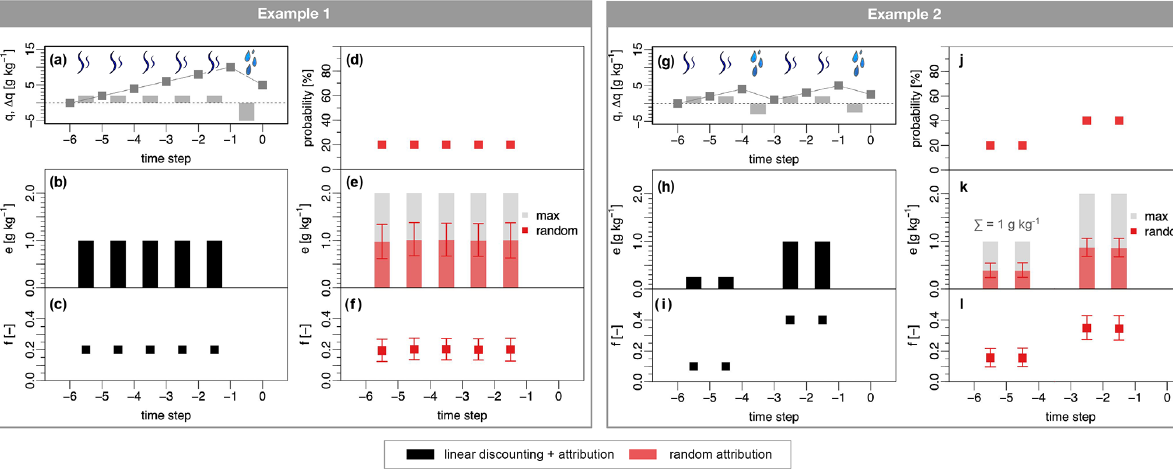
Figure 2. Illustration of backward-tracking precipitation from two idealized air parcel trajectories: (a, g) time series of specific humidity (dark grey lines and points) and specific humidity changes (grey bars) of the air parcels that lose moisture through precipitation at time step 0. The air parcels are each tracked backward in time for six time steps, during which they gained moisture through surface evaporation. In both examples (a, g) , the air parcel gains + 2gkg − 1 of moisture at each source and loses 50% of its specific humidity content during the (final) precipitation event. In the second example (g) , an additional rain event takes place en route at time step − 3, reducing the specific humidity to 1gkg − 1 . (b, h) The absolute contribution of each source to the precipitation event in step 0 as calculated with the linear attribution, assuming perfectly mixed conditions. In (h) , the absolute contributions of time steps − 6 and − 5 are lower because of the rain en route event. (c, i) Relative contributions as calculated with the linear discounting and attribution. (d, j) Probability of selection for each source time step or location as used in the random attribution that is based on the specific humidity content of the air parcel instead of specific humidity changes as employed for the linear discounting and attribution. (e, k) Maximum contribution for the random attribution (grey bars; assuming n min = 1 for illustration purposes) and absolute contribution (red bars) of each source to the precipitation event as calculated with the random attribution averaged over 1000 random attribution realizations. Error bars illustrate the interquartile range of these realizations (i.e., 25%–50%). (f, l) Corresponding average relative contributions and deviations as calculated with the random